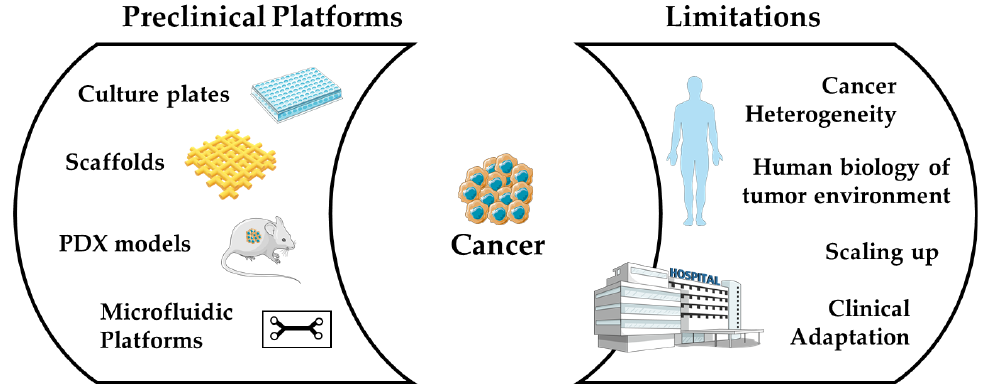
Figure 5. The dual view of cancer models: what already exists (left side) and what is hindering their arrival to the clinics (right side) (This schematic drawing is created using some images from Servier Medical Art (https://smart.servier.com (accessed on 18 September 2020)). Servier Medical Art by Servier is licensed under a Creative Commons Attribution 3.0 Unported License).